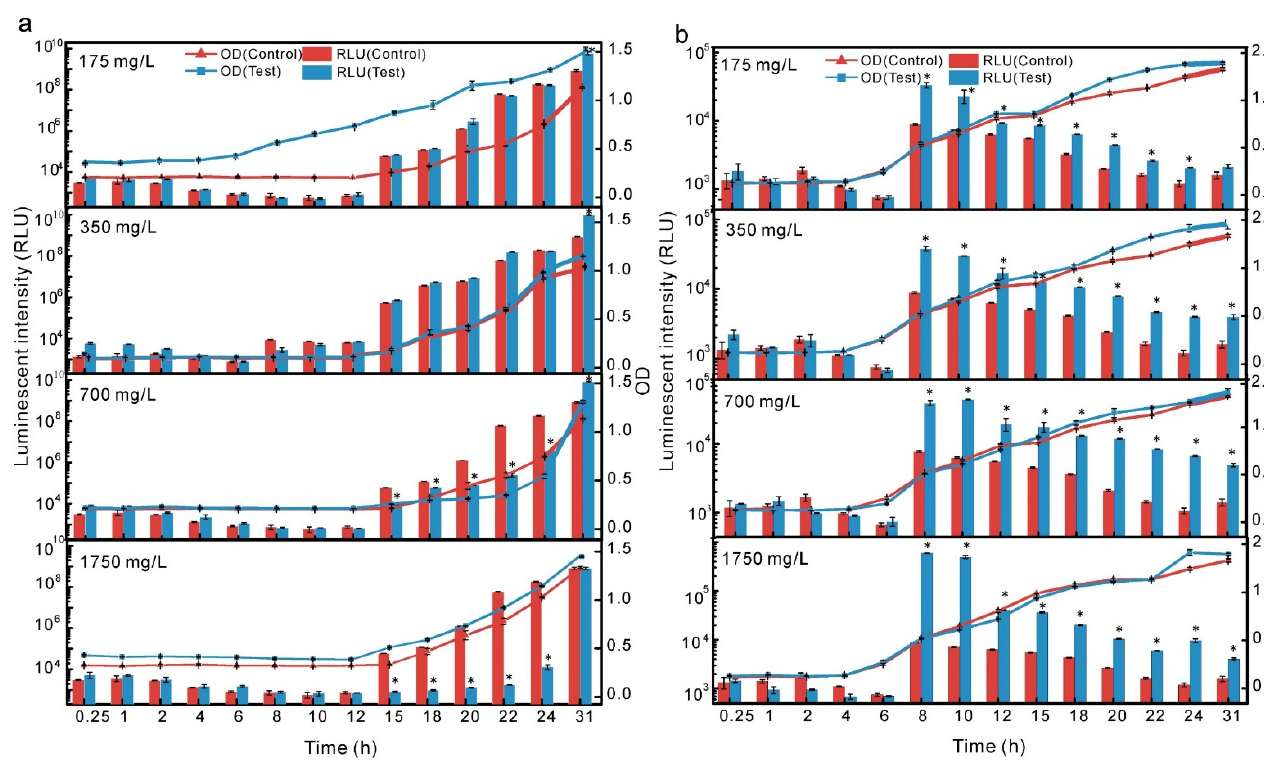
Figure 3. The variation of growth and luminescence level following the addition of crude extract at different concentrations in T3 ( a ) and Q67 ( b ). * represents p < 0.05.